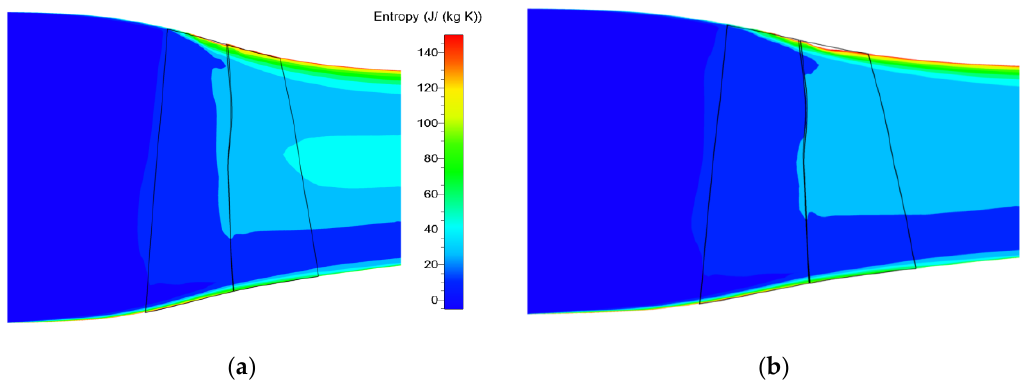
Figure 16. The entropy distribution of the mean flow surface of the original and optimized tandem rotor. ( a ) ORG; ( b ) OPT.